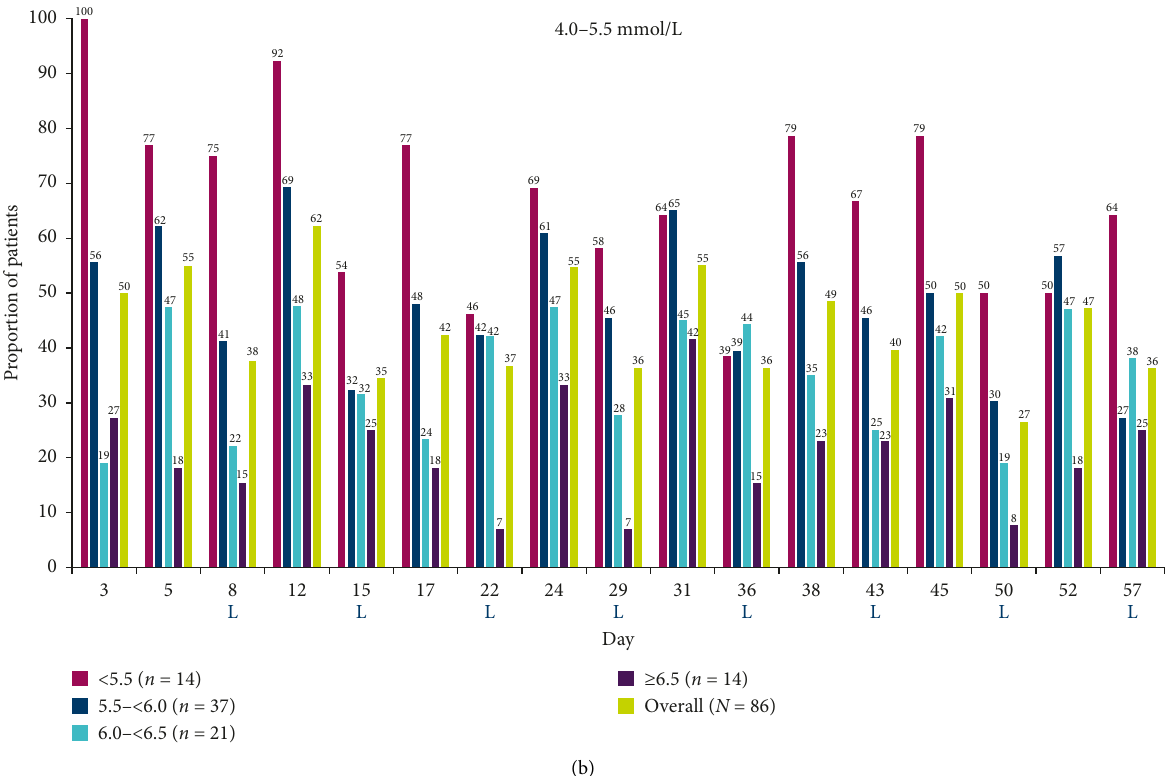
Figure 2: Proportions of placebo patients with predialysis sK + ranges of (a) 4.0–5.0 mmol/L and (b) 4.0–5.5 mmol/L at each study visit, by predialysis sK + concentration at randomization. Predialysis sK + measurement at randomization (visit 4, day 1) was used for subgroup stratification. Patients receiving rescue therapy were included in the analysis. No imputation of missing data was conducted. L represents the LIDI visits. LIDI, long interdialytic interval; sK + , serum potassium.